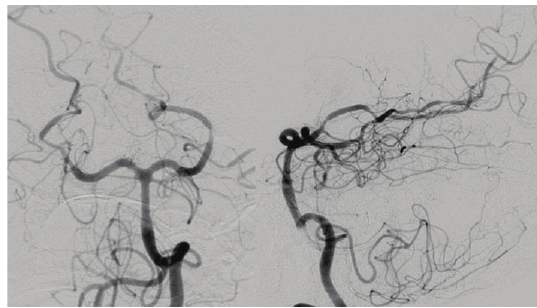
Figure 3: Left vertebral artery angiography, AP, and lateral views, demonstrating severe multifocal vasoconstriction but without any evidence of arteriovenous shunting or